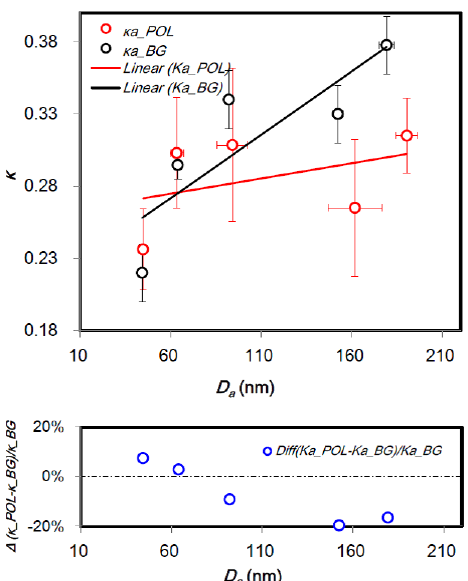
Figure 2. Derived hygroscopicity parameter, κ a , as a function of particle diameter, D a , under polluted (POL) and background (BG) conditions. Bottom: percent change in κ a due to pollution as a func- tion of D a . Error bars represent one standard deviation calculated over the entire measurement